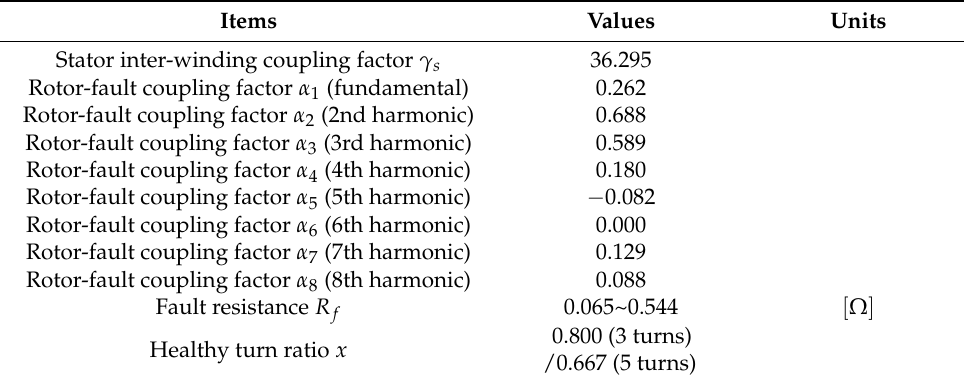
Table 2. Flux Coupling Factor and Fault